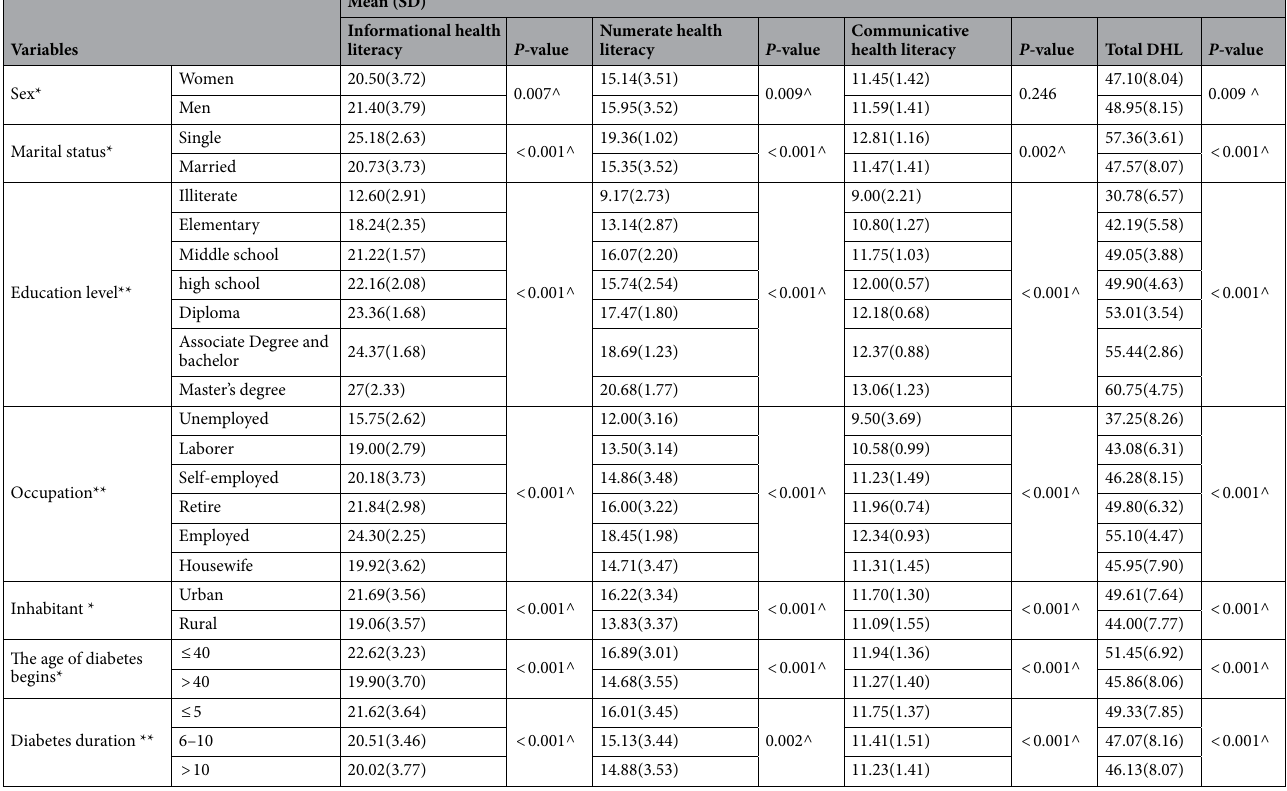
Table 2. Relationship between demographic variables and diabetes health literacy (DHL). * Independents sample T-test, ** One- Way ANOVA, ^ significance level <